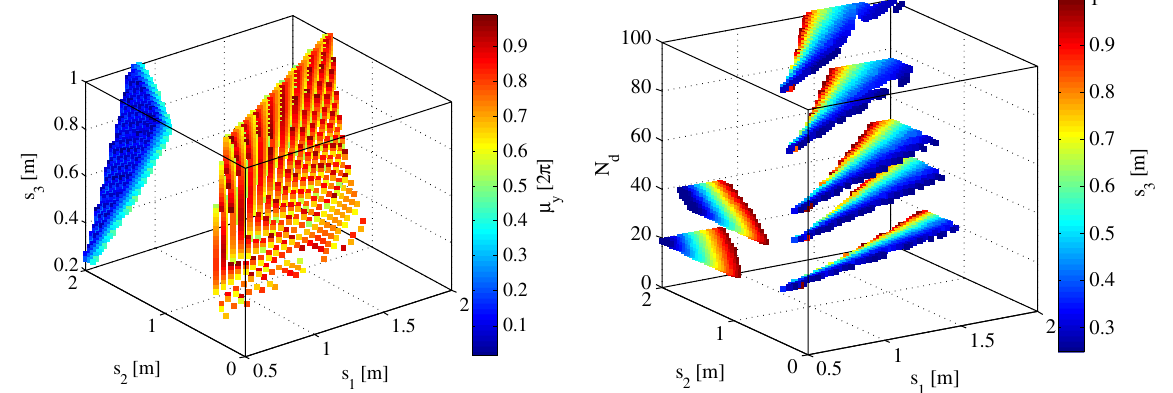
FIG. 2. Left: Parametrization of the vertical phase advance of a TME cell with a dipole bending angle of θ ¼ 2 π = 19 with the drift spaces lengths s 1 , s 2 , s 3 , when targeting the theoretical minimum emittance. Only solutions providing optical stability are presented. Right: The stability region in the ( s 1 ; s 2 ) plane for different theoretical minimum emittance targets ( ϵ color-coded with s 3